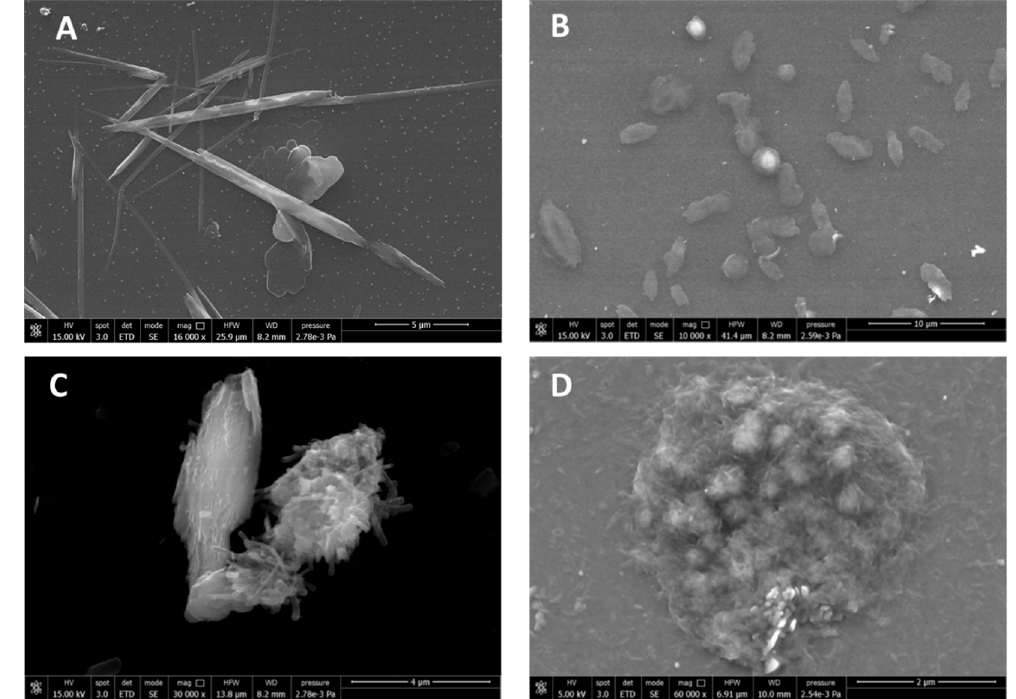
Figure 2. FE-SEM micrographs of ( A ) pure CN from deposition from diluted water suspension; ( B ) CN-NL complex; ( C ) and ( D ) CN-NL complex at higher magnification.